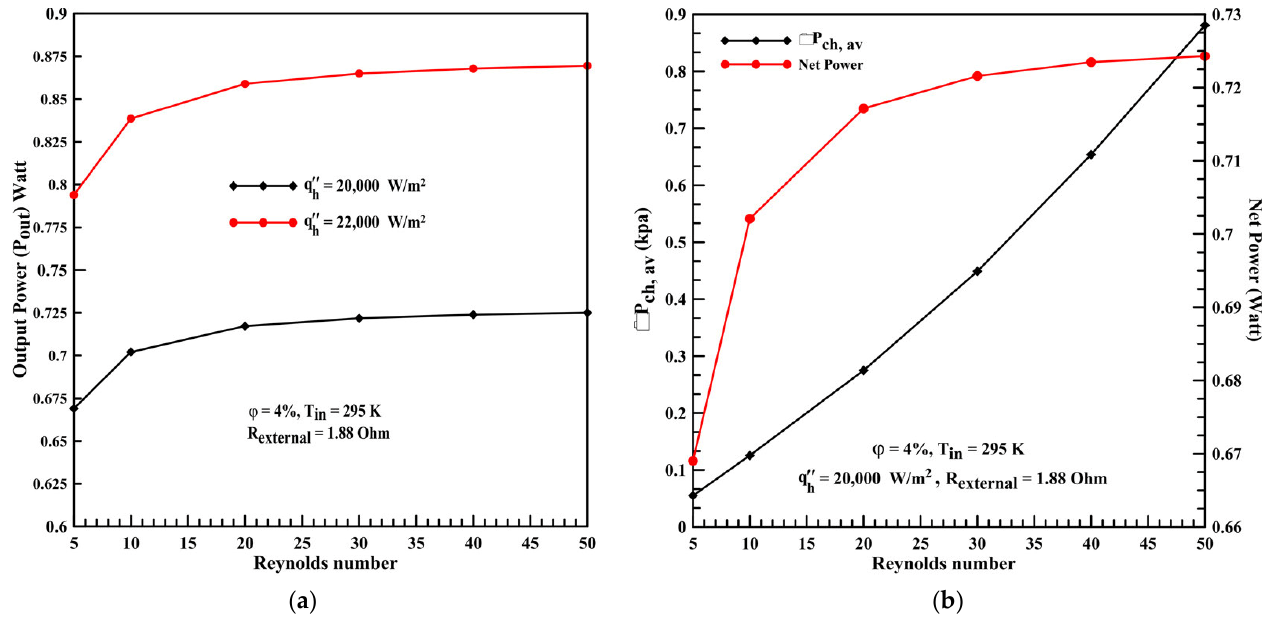
Figure 16. Solar powered TEG cooled by a zigzag microchannel: ( a ) Output power versus the low range of Reynolds number at two heat fluxes; ( b ) Average pressure drop and net output power versus the Reynolds number. Reprint with permission [83]; Copyright 2021, Taylor & Francis.